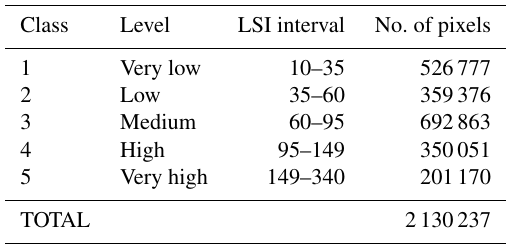
Table 3. Land susceptibility index (LSI) values for the classes